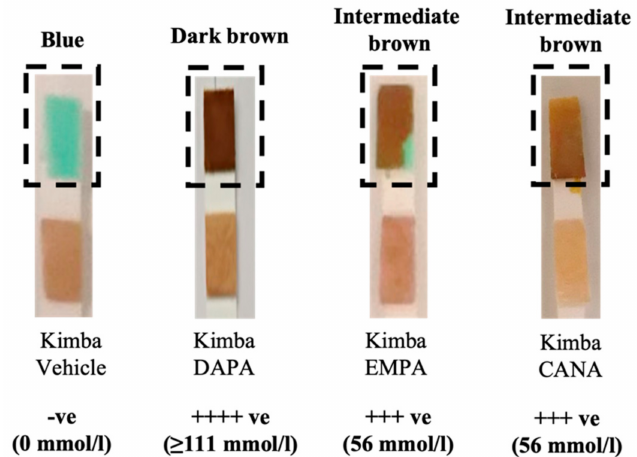
Figure 1. SGLT2 inhibition with DAPA, EMPA, and CANA promotes glucosuria in non-diabetic Kimba mice. DAPA: Dapagliflozin; EMPA: Empagliflozin, and CANA: